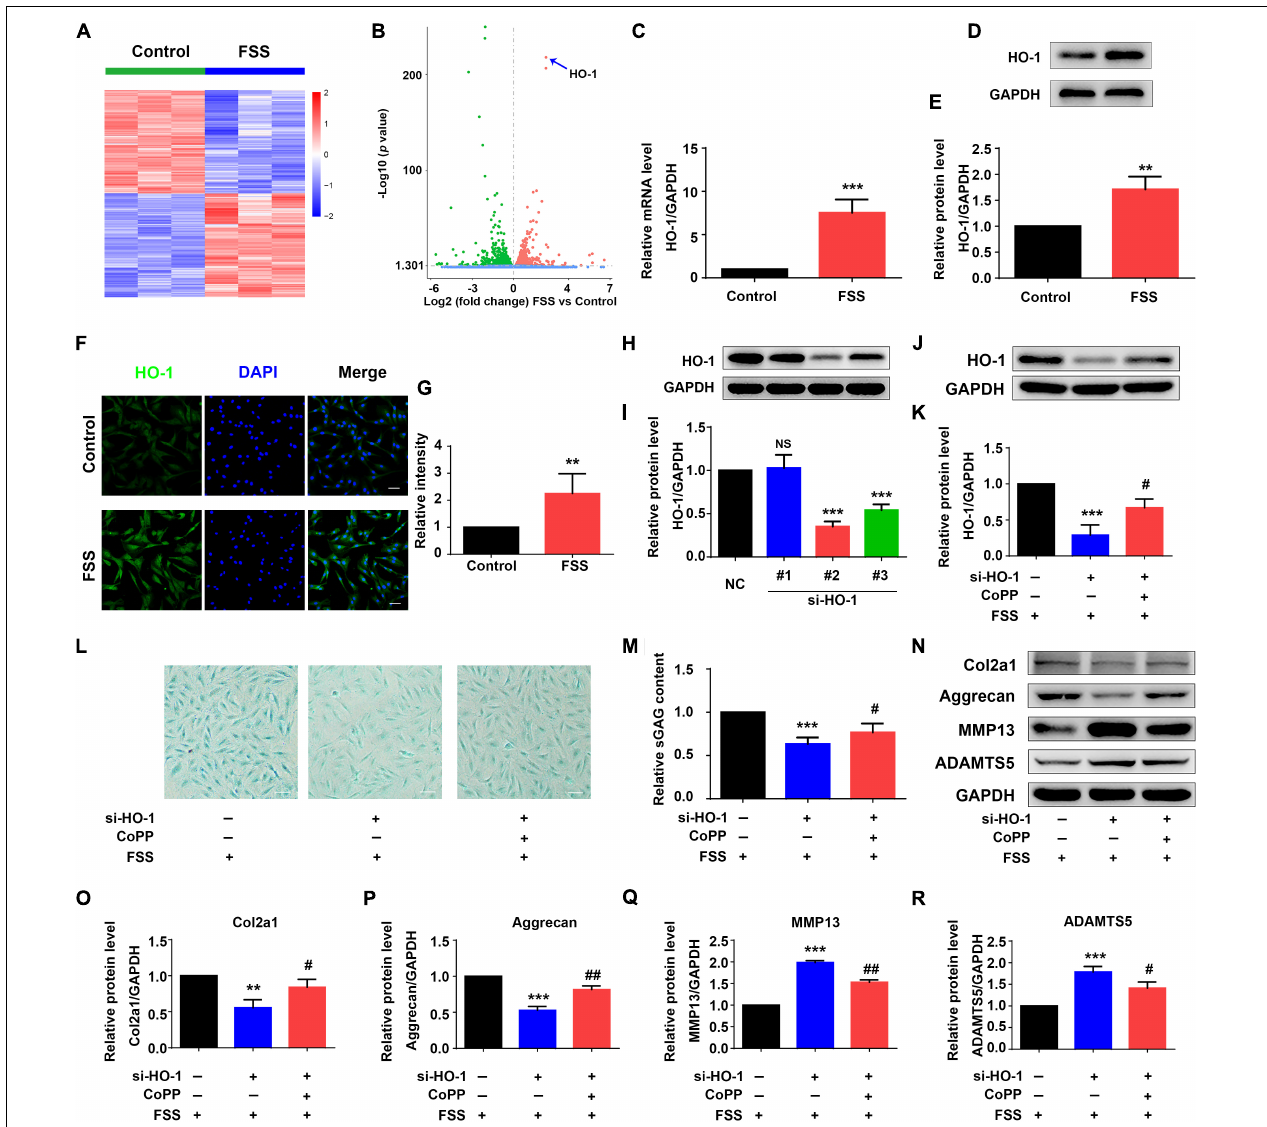
FIGURE 2 | Heme oxygenase-1 regulates FSS-mediated ECM production in NP cells. (A) The heat map of RNA-seq data. NP cells were treated with or without 12 dyne/cm 2 FSS for 2 h, followed by RNA-seq analysis as described in Materials and Methods. (B) Volcano plot of RNA-seq data. Blue arrow indicates heme oxygenase-1 (HO-1). (C) Quantitative real-time reverse transcriptase-polymerase chain reaction (qRT-PCR) analysis. NP cells were treated with or without 12 dyne/cm 2 FSS for 2 h, followed by qRT-PCR analysis. (D,E) Western blotting. NP cells were treated as in panel (C) , followed by western blotting. Quantitative data from three independent experiments (E) . (F,G) Immunofluorescence (IF) staining. NP cells were treated as in panel (C) , followed by IF staining (E) . Bar, 50 µ m. Quantitative data from three independent experiments (G) . (H,I) HO-1 siRNA knockdown. NP cells were transfected with negative control siRNA (NC-siRNA) and three HO-1-siRNA (#1, #2, #3). Then, cells were subjected to western blotting for HO-1 (H) . Quantitative data from three independent experiments (I) . Note: #2 HO-1-siRNA showed the best knocking down effect and was used for all following experiments in this study. (J,K) Western blotting. NP cells were transfected with negative control siRNA (NC-siRNA) and HO-1-siRNA (#2). Then, cells were pretreated with or without HO-1 inducer cobalt protoporphyrin IX (CoPP) (10 µ M) and subjected to 12 dyne/cm 2 FSS for 2 h, followed by western blotting for HO-1 (J) . Quantitative data from three independent experiments (K) . (L,M) sGAG content. NP cells were treated as in panel (J) , followed by alcian blue staining and Blyscan Sulfated Glycosaminoglycan Assay. Bar,100 µ m. Quantitative data of sGAG content from three independent experiments (M) . (N–R) Western blotting. NP cells were treated as in panel (J) , followed by western blotting for expression of the indicated proteins. Quantitative data from three independent experiments (O–R) . Results are expressed as mean ± standard deviation (s.d.). NS, no statistical significance, ** P < 0.05, *** P < 0.001 vs. control, NC or FSS + NC-siRNA group; # P < 0.01 and ## P < 0.01 vs. FSS + HO-1-siRNA group.